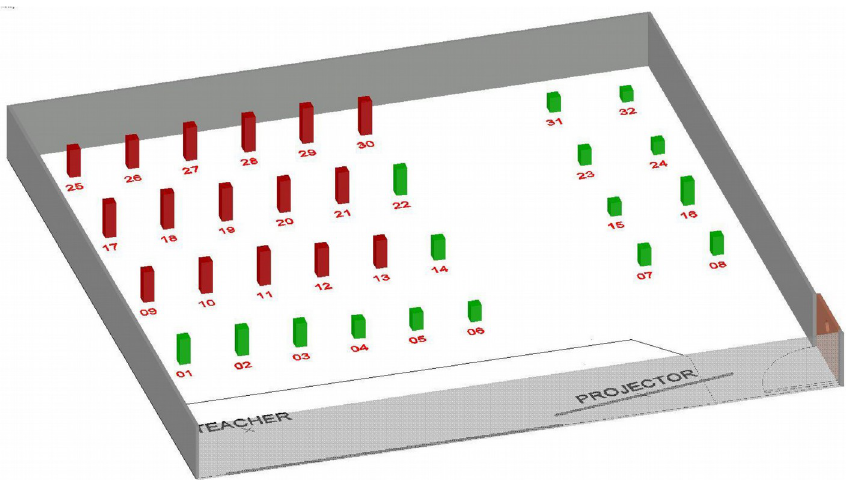
Figure 3. Occupation ratio of each computer. The height is proportional to the number of times used The N-PRAC (mark for class exercises) and the N-CTRL (mid-year mark) are very related (r = 0.68, p = 0.000). The students who obtain a good mark in the practical cases (exercises carried out in